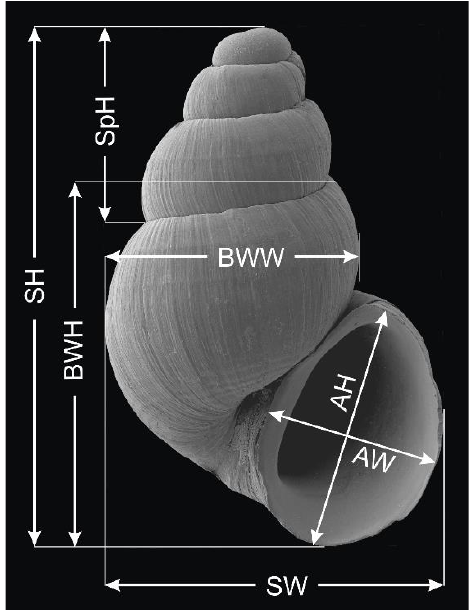
Figure 3. The standard measurements of the Clathrocaspia shell. Abbreviations: AH — aperture height; AW — aperture width; BWH — body whorl height; BWW — body whorl height; SH — shell height; SpH — spire height; SW — shell width.